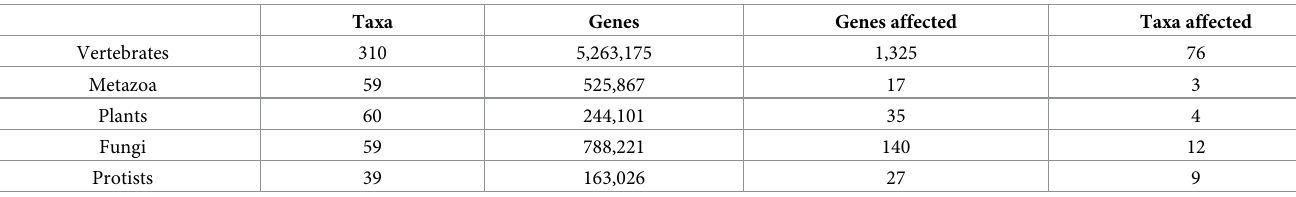
Table 2. Gene names vulnerable to date conversion across